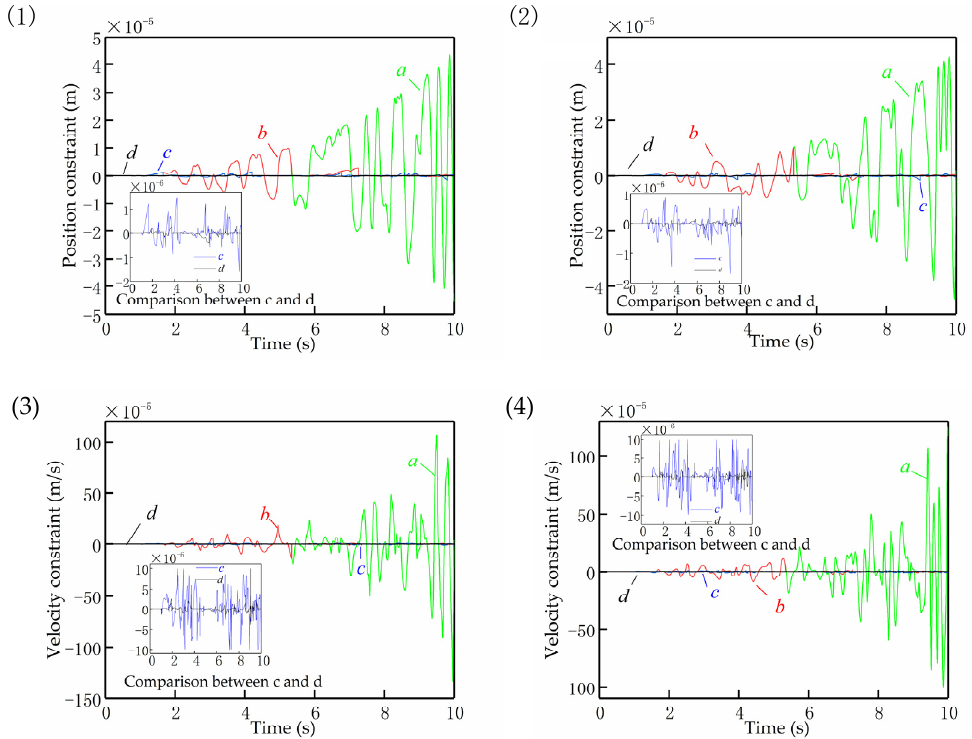
Figure 10. The violation of constraints in joint 14. (1) Position constraint violations in the x-direc- tion; (2) Position constraint violations in the y-direction; (3) Velocity constraint violations in the x- directional; (4) Velocity constraint violations in the y-directional.